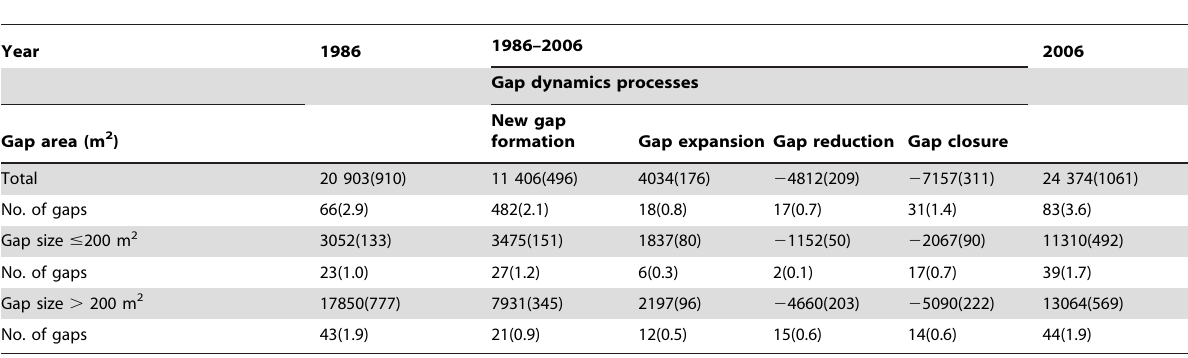
Table 3. Gap characteristics and gap dynamics processes in the Gorjanci forest